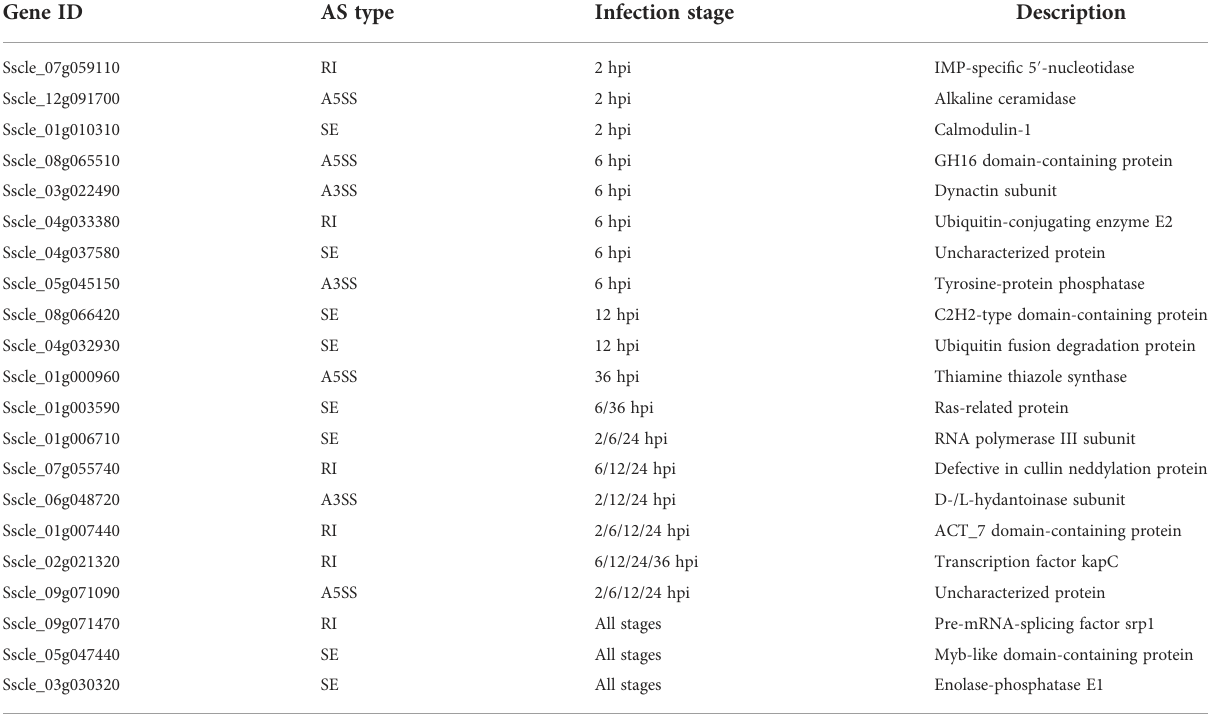
TABLE 2 Differential alternative splicing genes with pseudogenization.